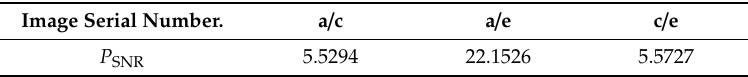
Table 2. The second set of gray data images mutual P SNR values.